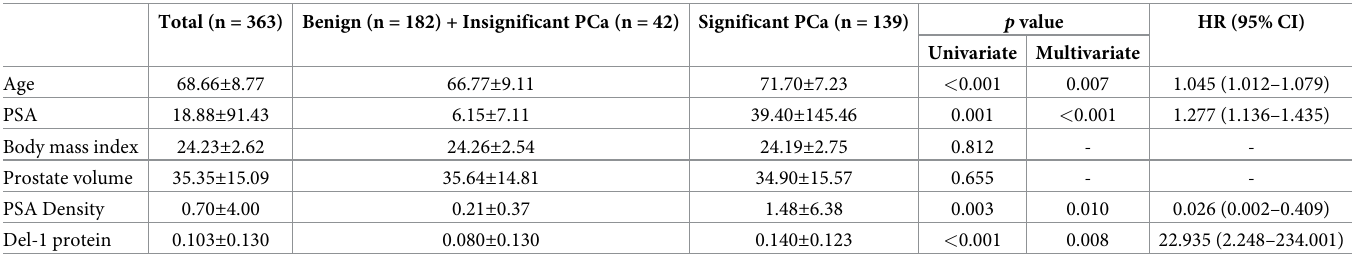
Table 6. Multivariate logistic regression analysis of De1-1 protein as prognostic marker for predicting significant prostate cancer. Total (n = 363) Benign (n = 182) + Insignificant PCa (n = 42) Significant PCa (n =